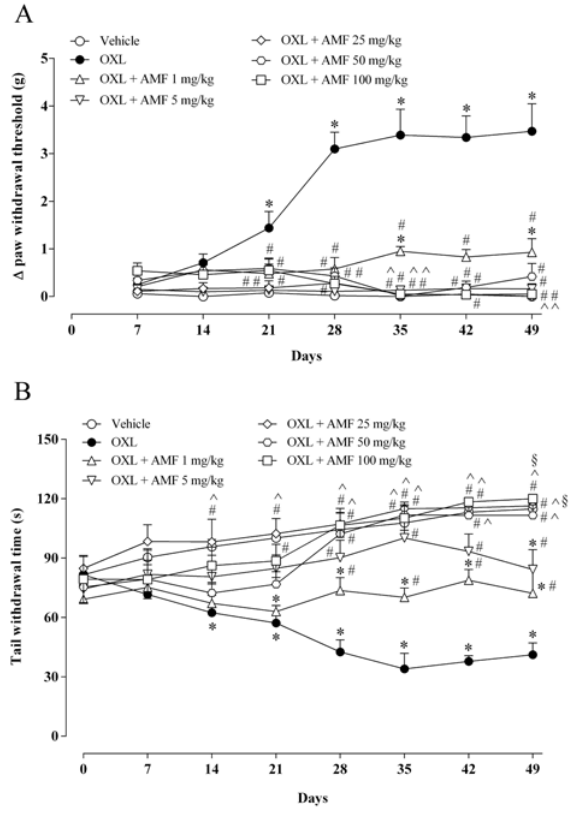
Figure 1. Effect of amifostine on behavioral tests. Oxaliplatin (OXL) (1 mg/kg) or 5% glucose (vehicle group) were injected intravenously, twice a week, for fi ve weeks (a total of nine injections). Amifostine (AMF) (1, 5, 25, 50, or 100 mg/kg) was administered subcutaneously 30 min before the oxaliplatin injection. Von Frey electronic test (mechanical hyperalgesia) ( A ) and tail immersion test in cold water (10°C) (cold allodynia) ( B ) were performed once a week, for 49 days. The results are reported as means ± SE. *P o 0.05 vs vehicle; # P o 0.05 vs OXL; ^P o 0.05 vs OXL + AMF 1 mg/kg; y P o 0.05 vs OXL + AMF 5 mg/kg (two-way ANOVA followed by Tukey